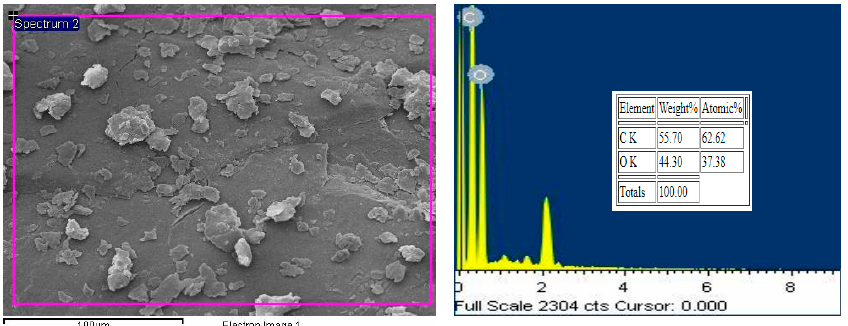
Figure 5. TEM image for CNC-CuO nanoparticle suspension. Molecules 2020 , 25 , 2975